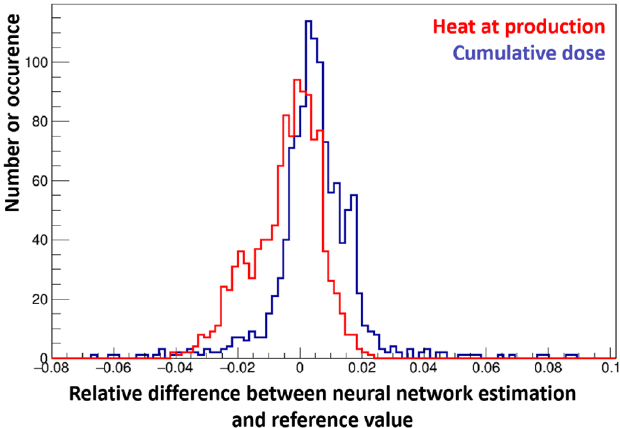
Fig. 5. Precision of decay heat at production and cumulative alpha dose over 10 000 years estimation for spent fuel burn-up higher than 30